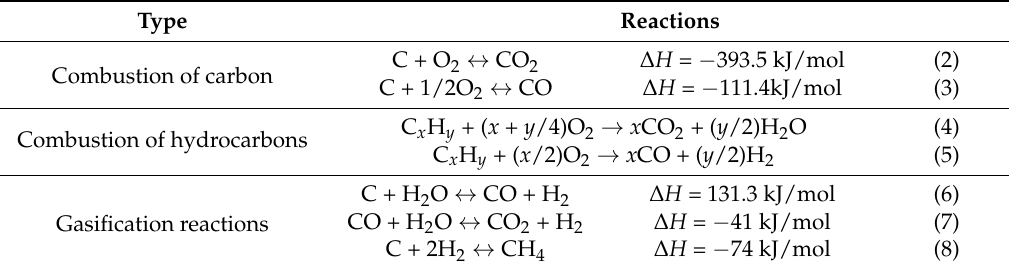
Table 1. Typical reactions during pyrolysis